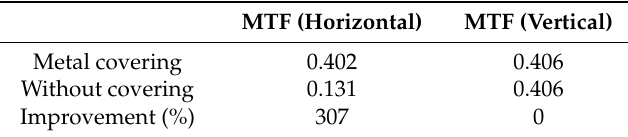
Figure 9. Measured MTF at 550nm wavelength: ( a ) Horizontal MTF; ( b ) Vertical MTF. Table 2. Measured MTF results with metal covering.